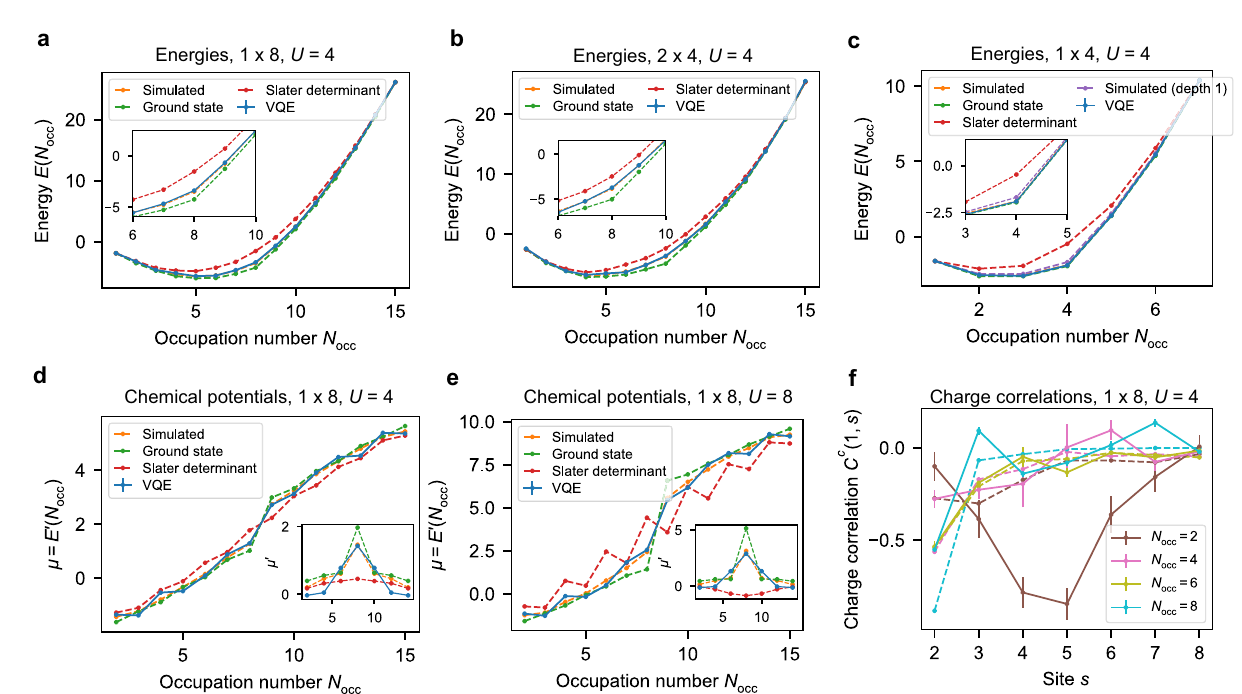
Fig. 4 | Experimental energies, chemical potentials and charge correlations. “ VQE ” : experimental data. “ Simulated ” : the lowest energy achievable in the VQE ansatz. “ Ground state ” : energy in the true ground state within each occupation numbersubspace. “ Slaterdeterminant ” :theenergyachievedbyanoptimisedSlater determinant state as detailed in Supplementary Note 5. Dashed lines are exact numericalcalculations,solidlineisexperimentaldata.Plotsshowapiecewiselinear interpolation between integer occupations. a – c Energies E ( N occ ) produced by VQE experimentscomparedwithexactresults( U =4).VQEresultsfor1×8and2×4use